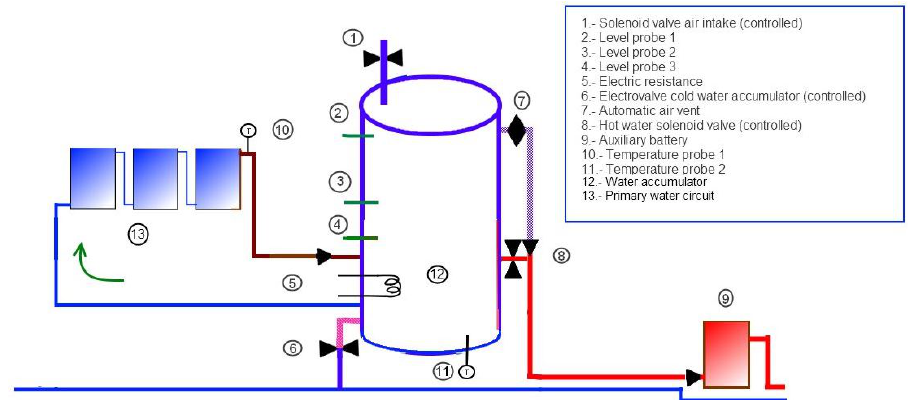
Figure 1. Components